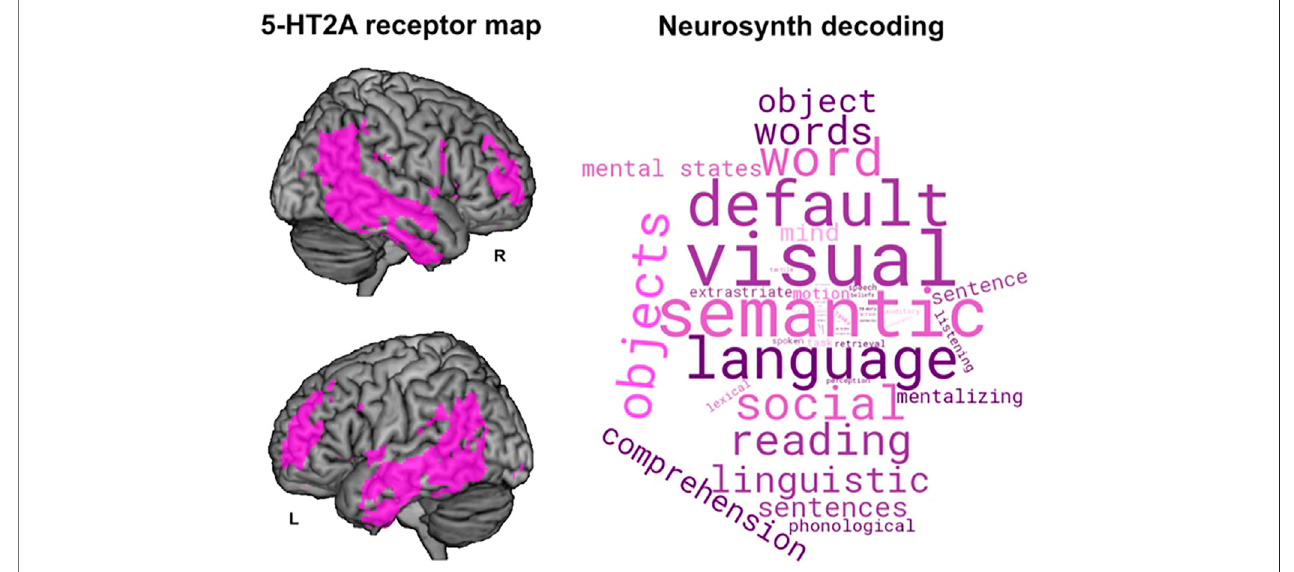
FIGURE2| Overlapbetweenregionspresentingahighdensityof5-HT2Areceptorsandthoseconsistentlyinvolvedinlanguageunderstandingandproduction,as determined by Neurosynth meta-analytic activation maps (Yarkoni et al., 2011). The 5-HT2A receptor density map (left) was obtained from 95 healthy subjects using PositronEmissionTomography(PET)with[ 18 F]altanserinasaradioligand(Saulinetal.,2012).ThewordcloudontherightwasobtainedusingNeurosynth ’ sdecodertool applied to the 5-HT2A receptor density map (https://neurosynth.org/decode/). Only terms associated with human cognitive functions were retained in the word cloud; those of neuroanatomical origin (e.g., cingulate cortex, insula) were